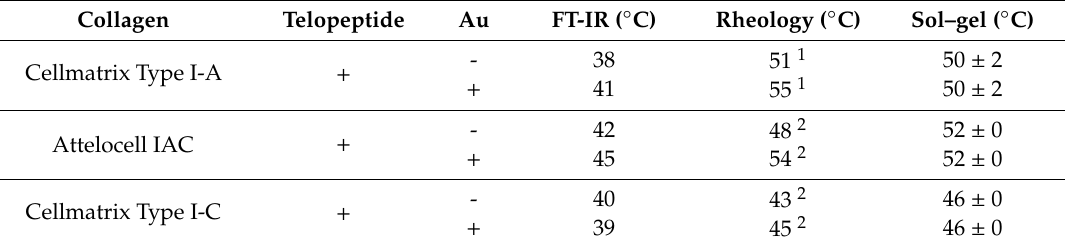
Figure 7. Sol–gel experiment of AuNP-embedded collagen gels. ( A ) Cellmatrix type I-A and ( B ) Cellmatrix type I-C. Table 2. Denaturation temperatures estimated from FTIR spectra, rheological analysis, and the sol–gel experiment.